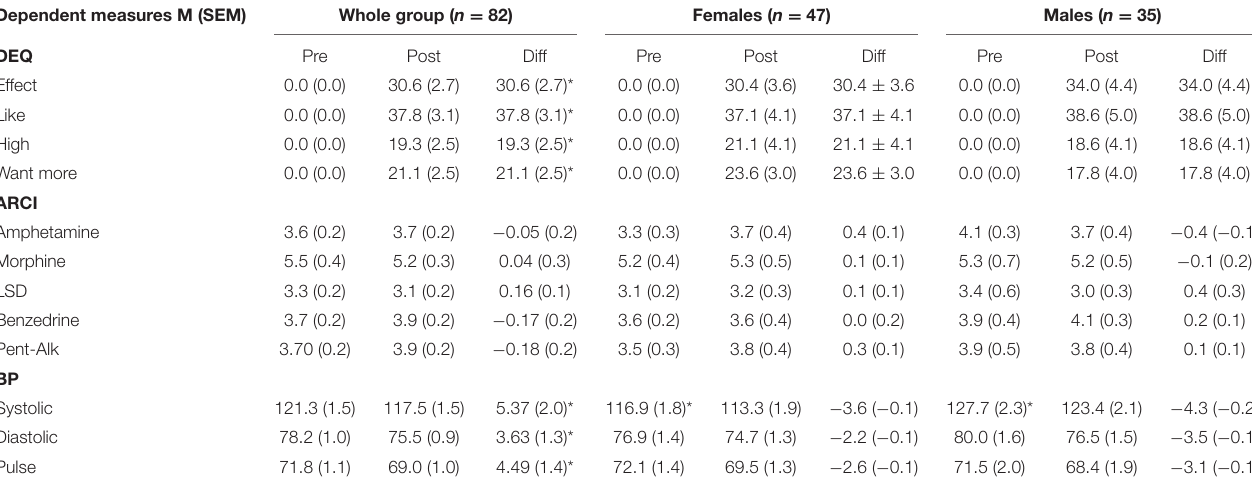
TABLE 2 | Subjective and objective effects between men and women after the online gambling task. Dependent measures M